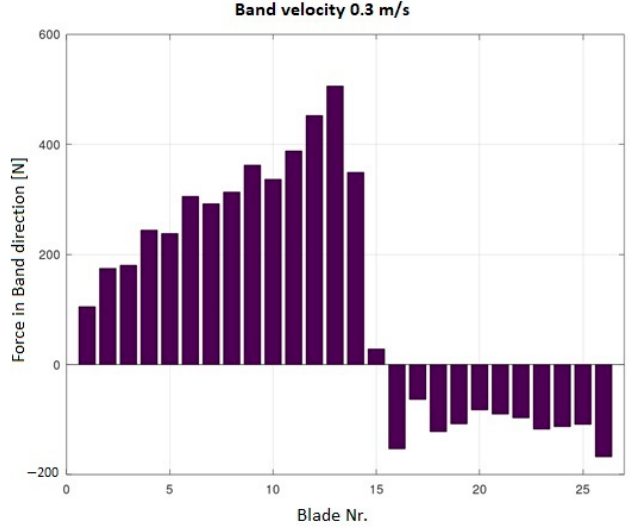
Figure 7. Force acting on each blade in the band direction.